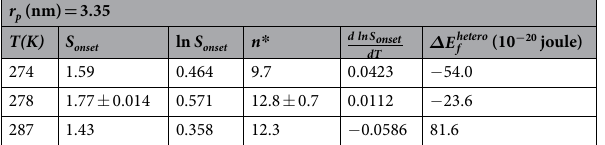
Table 1. Model-independent parameters. S onset and n * are from fits to the Gumbel distributions shown in Fig. 1. The last column gives the energy of formation of the critical cluster from an equal number of molecules of bulk liquid, Δ E fhetero , using Equation (9). Uncertainty limits at = T K 278 are from Ref. 7